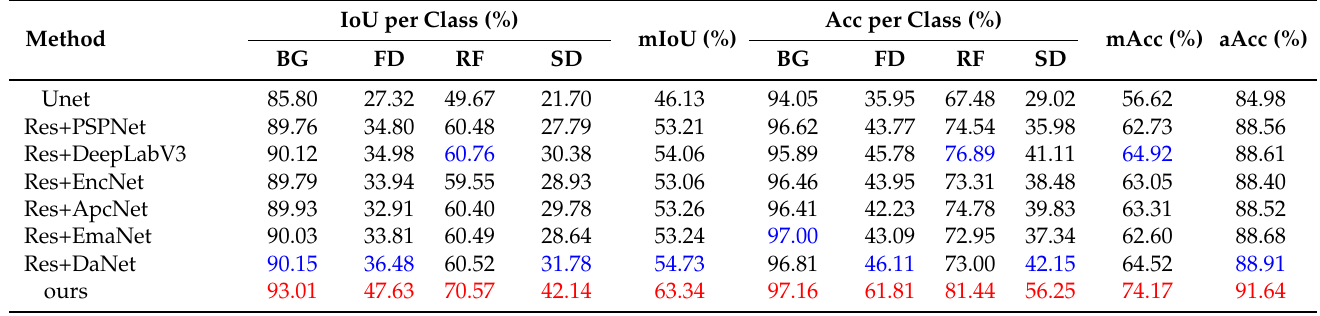
Table 1. Comparison of the results of our method and other SOTA methods for semantic segmentation on the SARMV3D-BIS dataset.